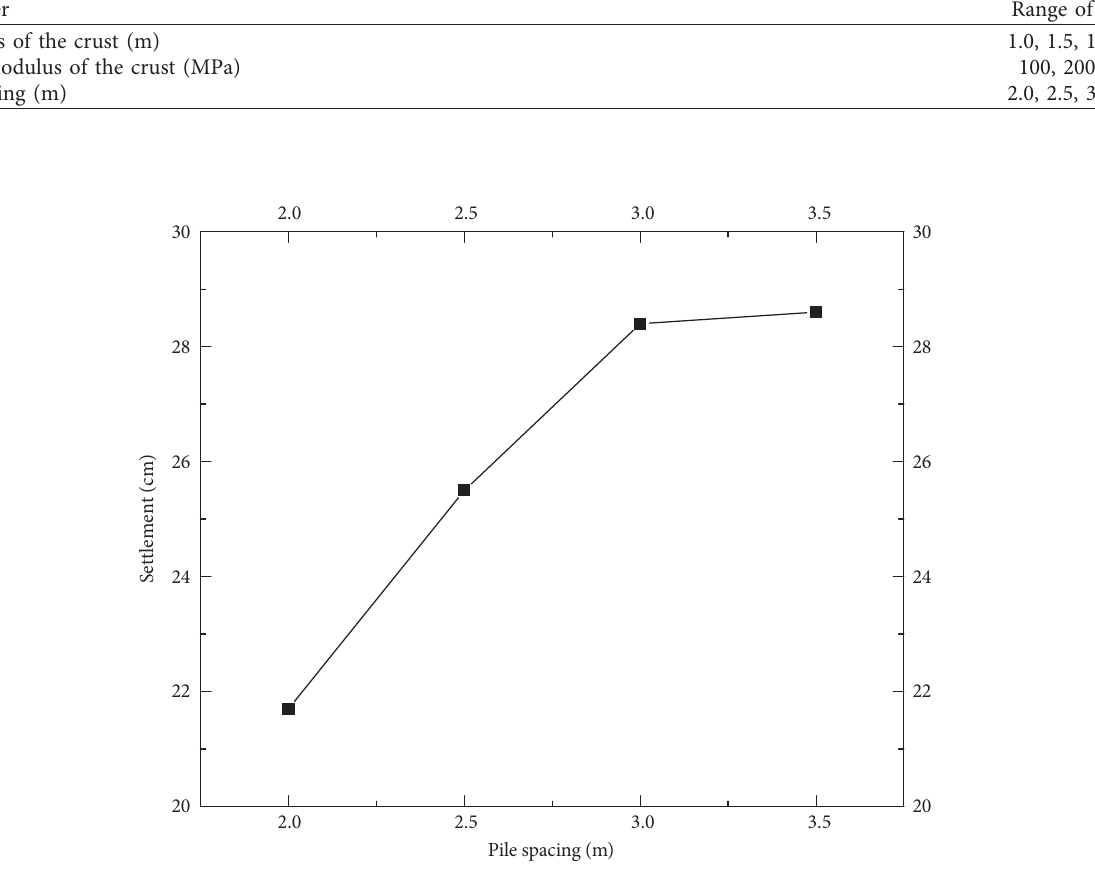
Figure 6: Maximum settlement versus pile spacing.